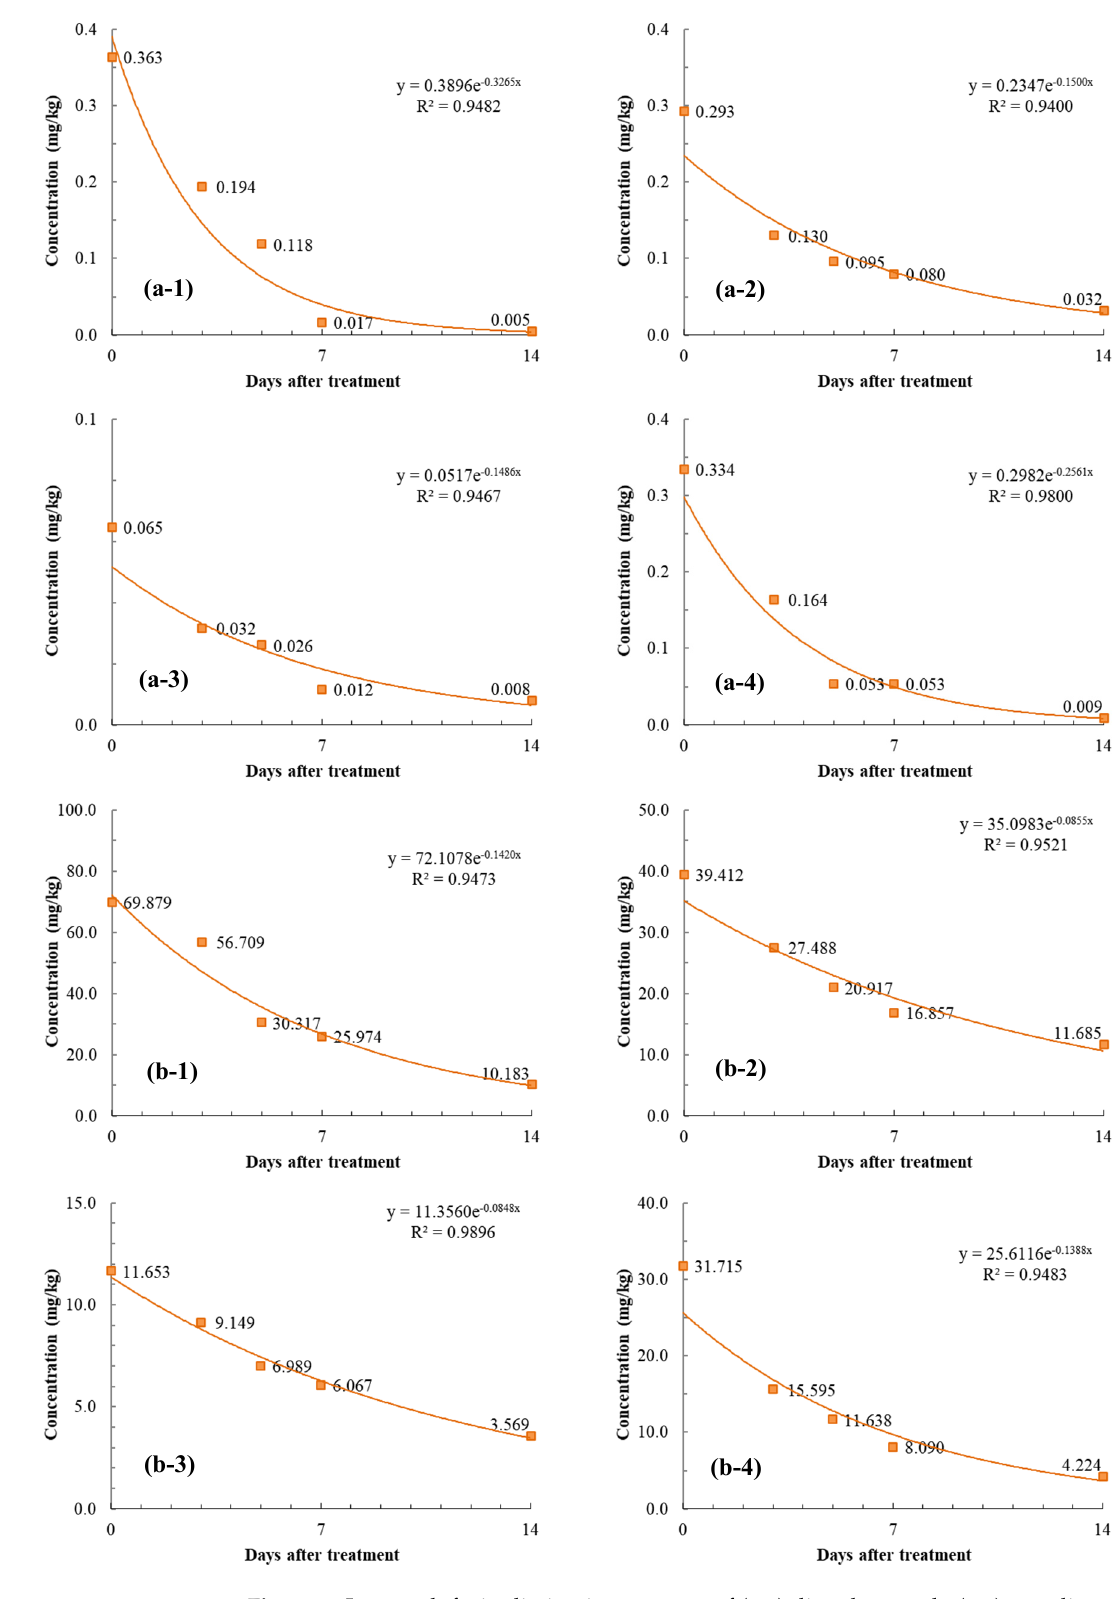
Figure 2. In squash fruit, dissipation patterns of ( a-1 ) dimethomorph, ( a-2 ) mandipropamid, ( a-3 ) myclobutanil, ( a-4 ) metalaxyl. In squash leaf, dissipation patterns of ( b-1 ) dimethomorph, ( b-2 ) mandipropamid, ( b-3 ) myclobutanil, ( b-4 ) metalaxyl. The residual levels of all pesticides decreased as the harvest date after the last spray- ing was postponed, and the correlation coe ffi cients of dissipation kinetics were in the range of 0.94–0.98 (Figure 2). Figure 2 show the regression curves and dissipation equa- tions of the four pesticides evaluated by fi rst-order kinetic analysis in squash fruit and leaf. The half-lives of all pesticides were shorter in fruit than in leaf. In this study, it is hypothesized that the signi fi cant di ff erence observed between the pesticides’ half-life in squash fruit and leaf could be due to the e ff ect of dilution during plant growth [28]. In squash fruit, the half-lives of dimethomorph, mandipropamid, myclobutanil, and metalaxyl were 2.1, 4.6, 4.7, and 2.7 days, respectively. In previous studies, the half-lives of various pesticides were reported: chlorfenapyr (3.05 days) [16], sulfoxa fl or (6.13 days) [17], tebuconazole (2.30 days), triadimenol (2.81 days), and myclobutanil (2.98 days) [18]. In fi eld experiments, increasing temperature accelerates numerous processes associated with pesticide dissipation [28–31]. Moreover, the higher the air humidity, the higher the pesticide adsorption a ffi nity to the plant surface and the lower its volatilization [32,33]. In a previous study on myclobutanil residues in squash fruit [18], the average temperature and average humidity during fi eld experiments were reported to be 13 °C and 60%, re- spectively. In this study, the average temperature of 18 °C and the average humidity of 71% were relatively high and likely contributed to the short half-life of the pesticide; how- ever, various factors involved in its half-life (e.g., microbial activity, rainfall, and sunlight) appear to have been combined. The half-lives of dimethomorph, mandipropamid, myclo- butanil, and metalaxyl in squash leaf were 4.9, 8.1, 8.2, and 5 days, respectively. Conse- quently, their half-lives were higher in squash leaf than in squash fruit. Unlike squash fruit, no studies have been reported on the half-lives of these pesticides in squash leaf. Previous studies have shown that dimethomorph tends to decompose quickly in ice- berg le tt uce (0.86 days) [34] and pepper (3.2–3.8 days) [35], but slowly in potato (9.4 days) [36], grape (9–9.8 days) [37], and pak choi (6.2 days) [38]. Mandipropamid has been re- ported to have a short or a similar half-life in grape (2.2 days) [39], Korean cabbage (3.9–4 days) [40], and sesame leaf (5.1–5.4 days) [41]. A few studies on myclobutanil half-life showed similar trends, reporting 2.2–3.4 days for lychee [42], 2.5–4.5 days for wheat [43], and 4.9–6.8 days for green tobacco leaf [44]. Regarding the chemical classes, the dissipa- tion half-lives of triazoles were reported to be in the range of 2–12.8 days [45], which is similar to our results and previous studies. The half-life of metalaxyl was reported to be 2.5 days in Chinese cabbage [46], 3–3.5 days in cucumber [47], 4.9 days in grape [37], and 16.5 days in durian leaf [48]. The decomposition behavior of pesticides is generally in fl u- enced by many factors such as their physicochemical characteristics, formulations, envi- ronmental conditions, crop species, and plant growth-based dilution factor [29,49,50].